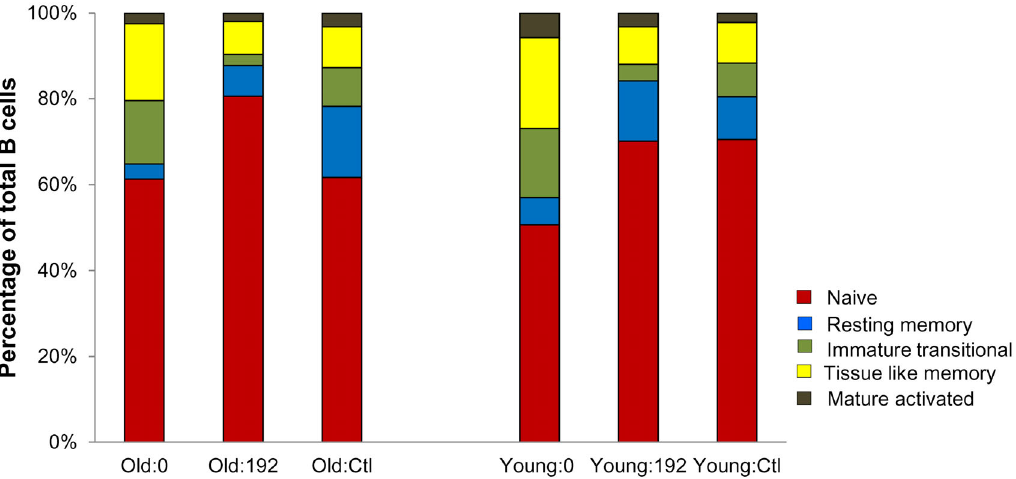
Figure 2. B cell phenotype distribution before and after antiretroviral therapy. Change in phenotype distribution in old and young age groups compared with their respective age-matched controls. 0 and 192 refer to time on ART in weeks; Ctl refer to respective age matched